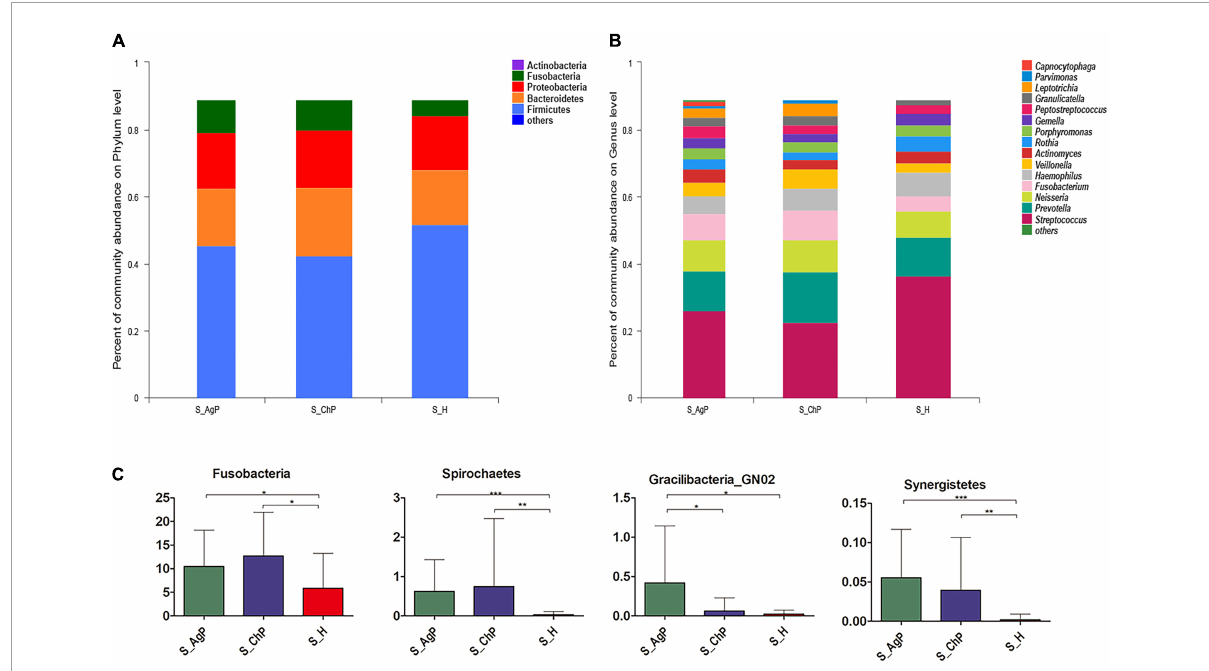
FIGURE1 Bacterial composition of three groups. Microbial community composition at the phylum level (A) and genus level (B) of salivary samples in the aggressive periodontitis group (shown as S_AgP), chronic periodontitis group (shown as S_ChP), and healthy group (shown as S_PH). The relative abundance of bacterial taxa at the phylum level shows significant differences among groups (C) . * p < 0.05; ** p < 0.01; *** p < 0.001.